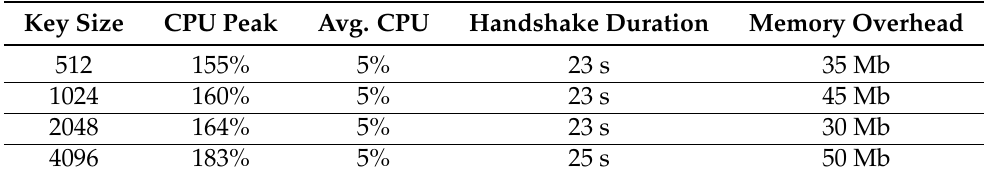
Table 3. The Performance of the TLS_ECDHE_RSA_WITH_AES_128_GCM_SHA256 Experiments. Key